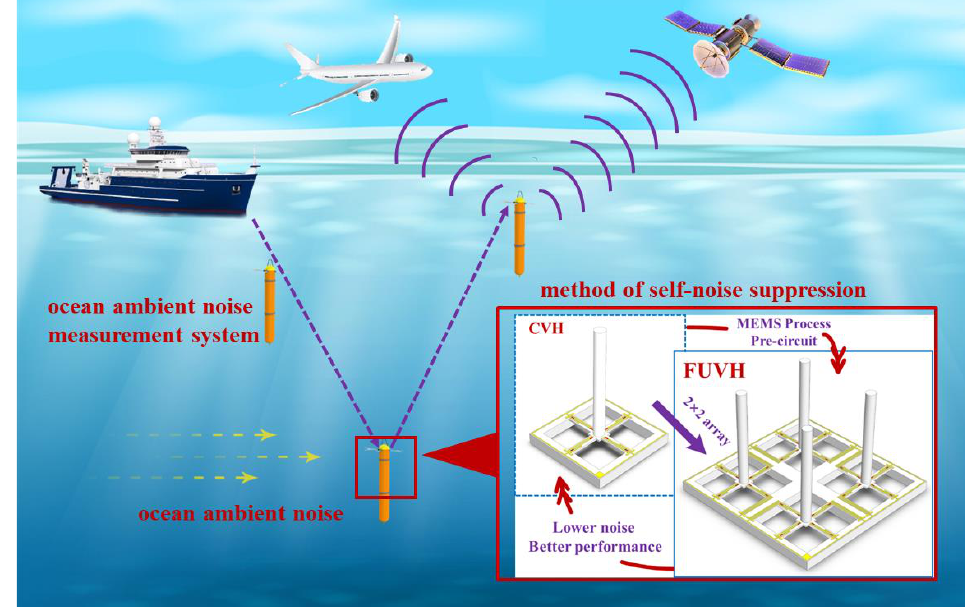
Figure 1. Working sketch of ocean ambient noise measurement system.